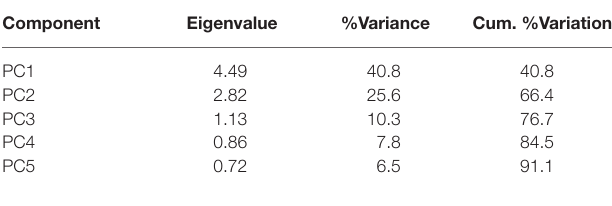
TABLE 2 | Eigenvalues, percent of total variance (%Variance), and percent of cumulative variation (Cum. %Variation) explained of the first five principal components (PC) of the principal component analysis (PCA) on environmental variables.